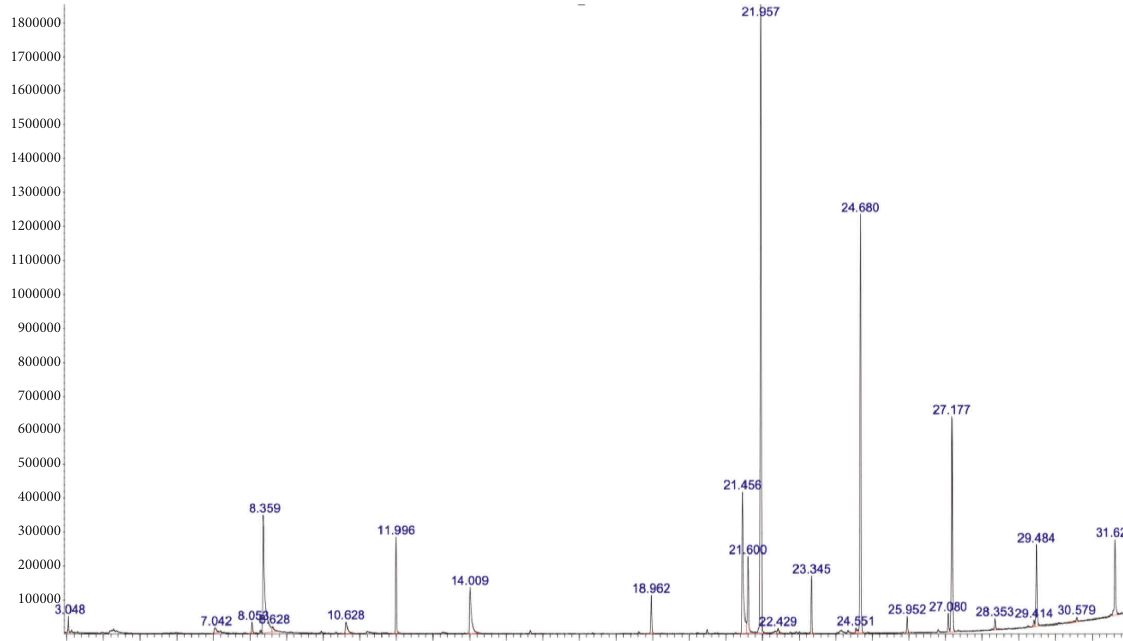
Figure 5: Chromatogram of volatile compounds of R. damascena buds.